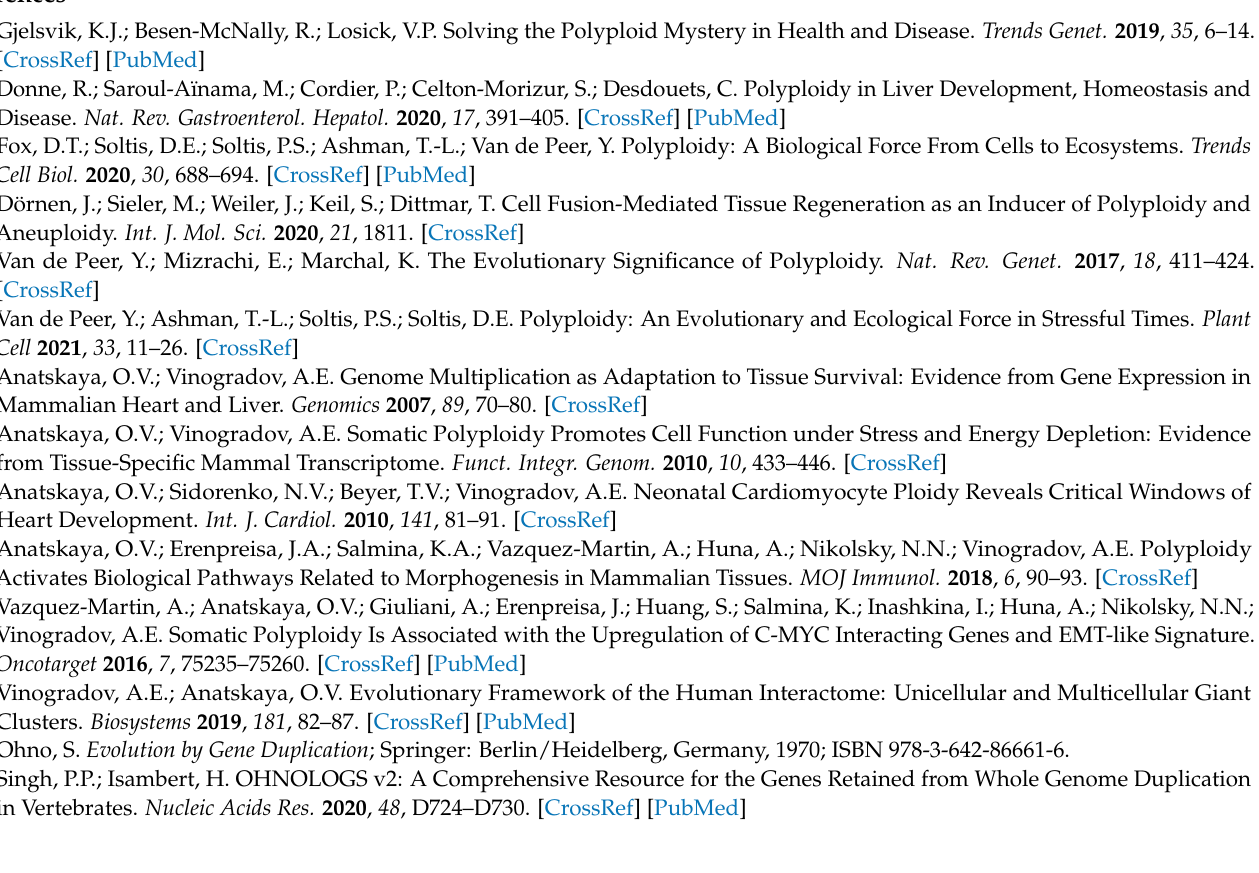
figure preparation; A.E.V.—conceptualization, writing original draft, review and editing and figure preparation. All authors have read and agreed to the published version of the